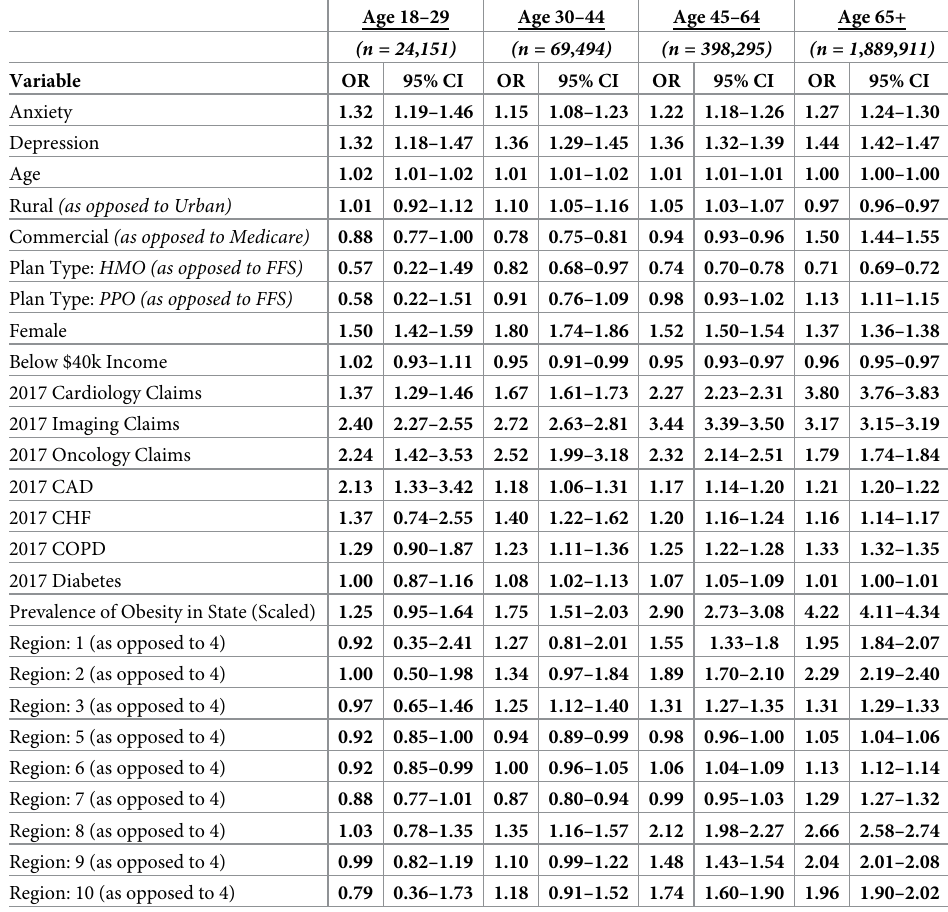
Table 3. Adjusted odds ratios for factors influencing any imaging, by